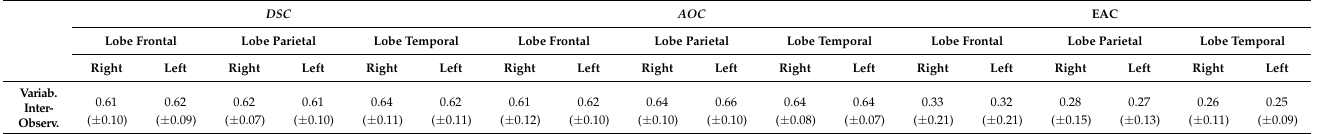
Table 4. Results of inter-observer